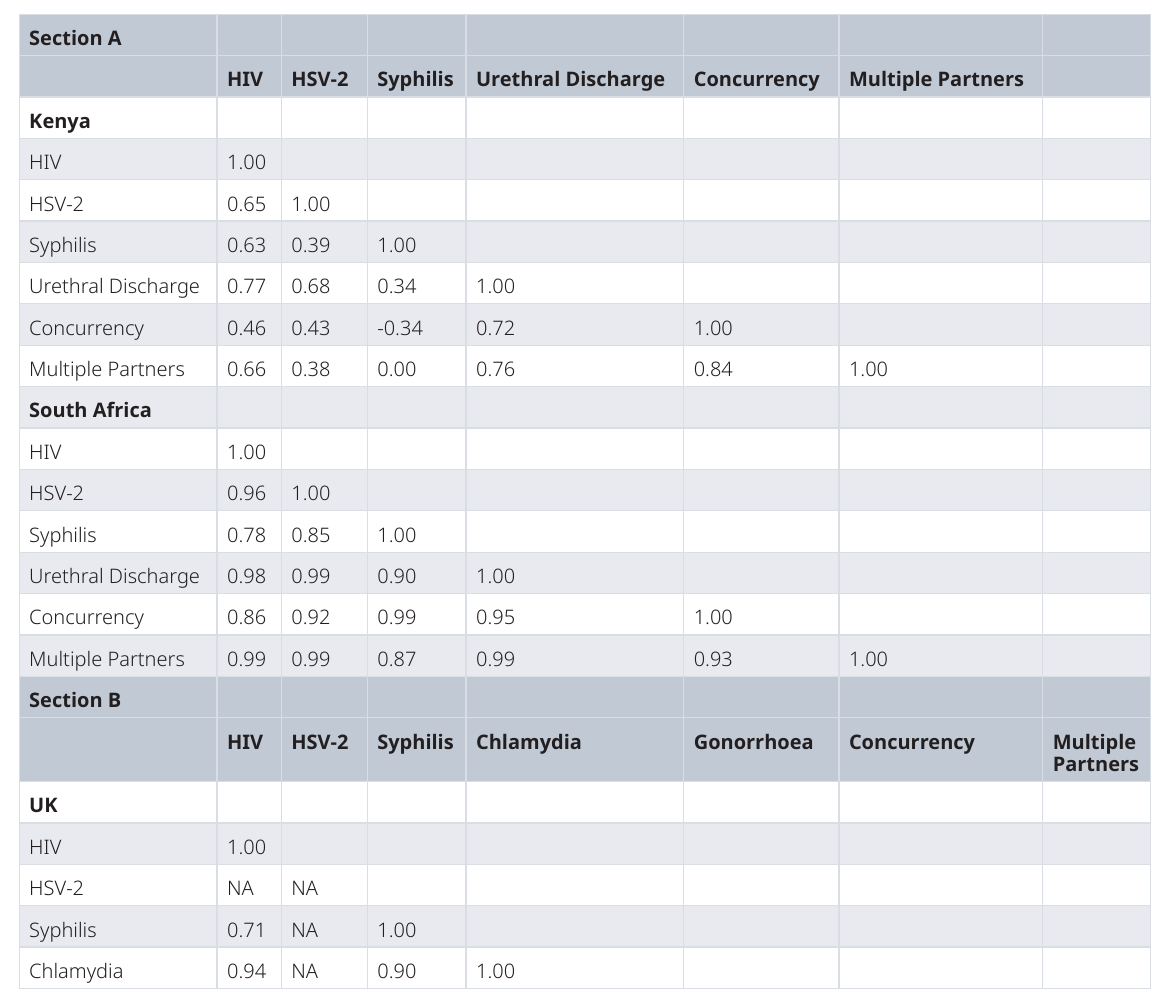
Table 6. Associations between incidence/prevalence of HIV, HSV-2, syphilis, gonorrhoea, chlamydia, male urethral discharge, concurrency and multiple partnering by ethnic group in (A) Kenya and South Africa; and (B) the United Kingdom and United States (Pearson’s